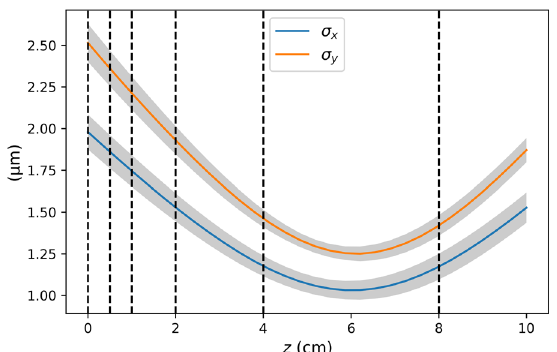
FIG. 7. Evolution of the reconstructed beam size around the waist. The dashed vertical lines indicate wire scan measurement locations along z . At each of the six locations wire scans are carried out along nine different angles. Since we expected the waist to be around z ¼ 0 cm, the distance between measurements is reduced